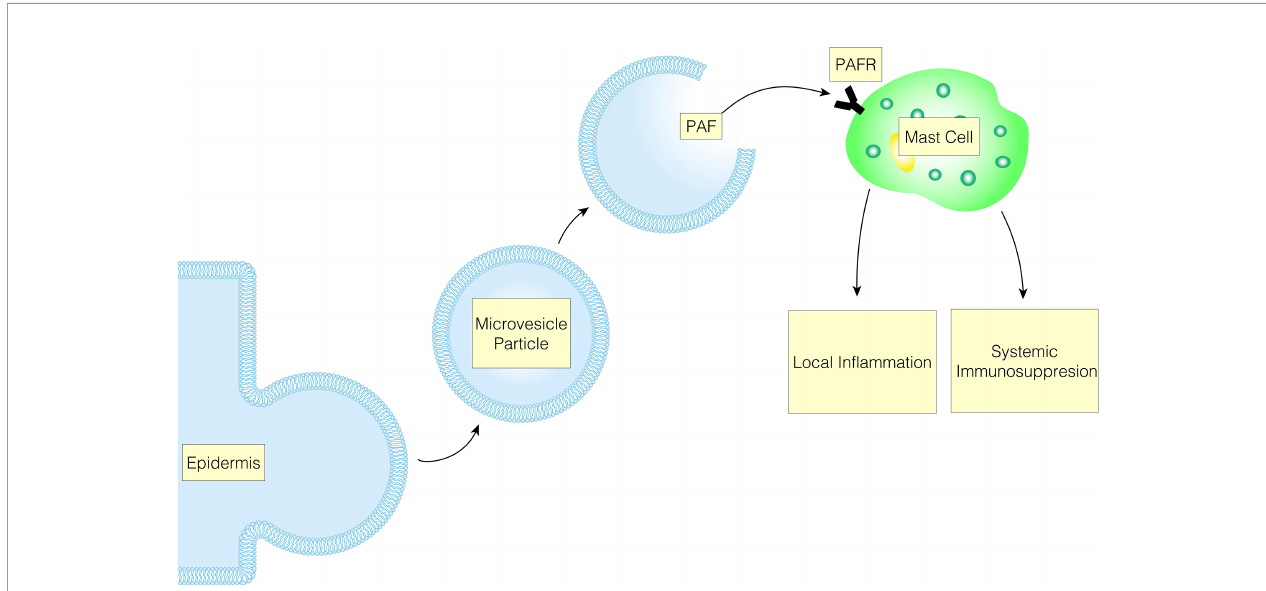
FIGURE 2 | UVB oxidized-GPC results in PAFR activation, causing MVP to be released from the keratinocyte plasma membrane, allowing PAFR agonist to be transported to additional